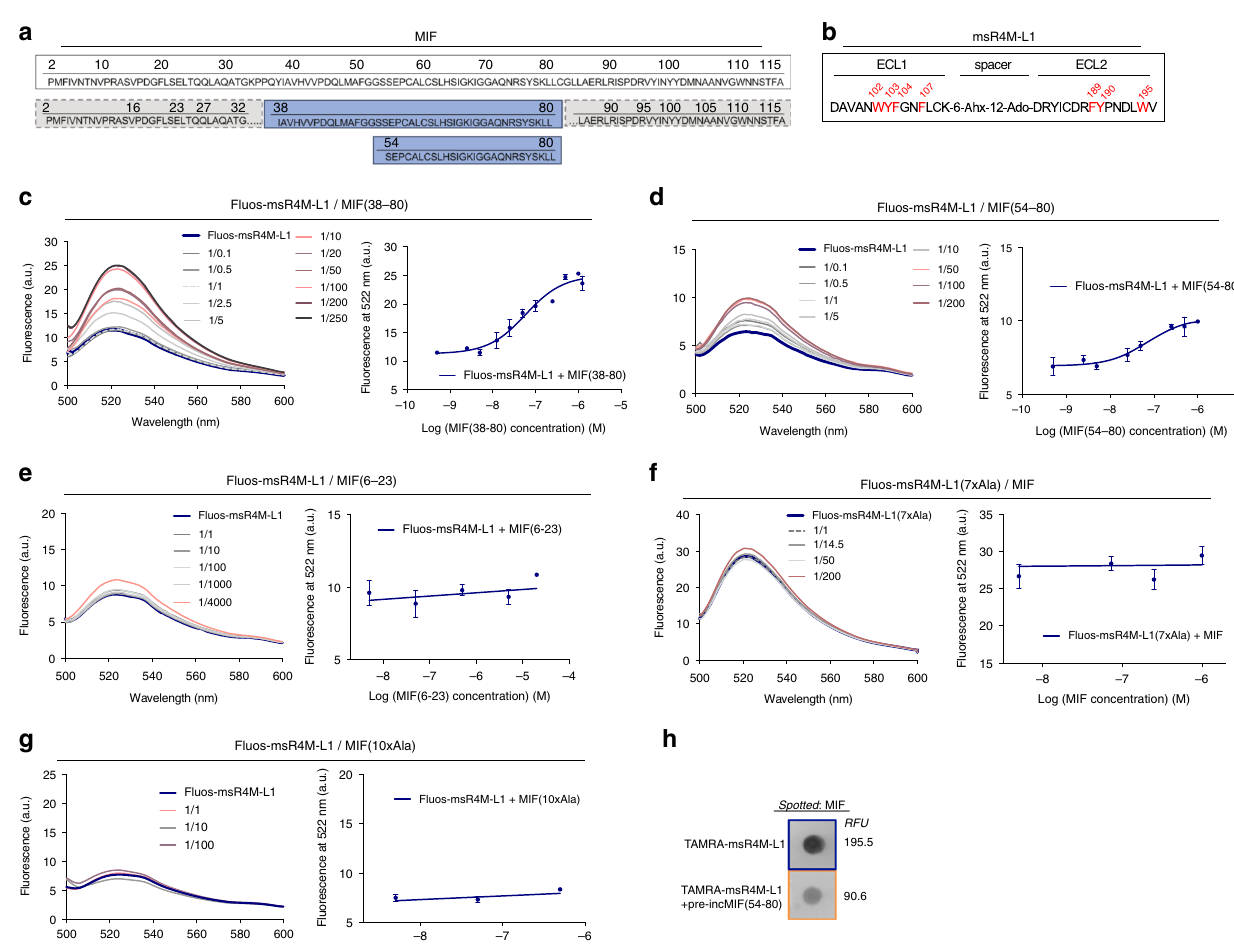
Fig. 2 Mapping of the MIF/msR4M-L1 core binding region and complex disruption by mutations. a Amino acid sequence of human MIF (boxed, top). The msR4M-L1 binding core region of MIF (sequence 38 – 80 and 54 – 80) is indicated in blue, while non-binding stretches are in gray (bottom). b Sequence of msR4M-L1. Aromatic residues identi fi ed by peptide array to be critical for MIF binding are highlighted in red. c – e Nanomolar af fi nity binding of msR4M- L1 to MIF(38 – 80) ( c ) and MIF(54 – 80) ( d ), but not MIF(6 – 23) ( e ), as determined by fl uorescence spectroscopy. Emission spectra of Fluos-msR4M-L1 alone (blue; 5 nM) and with increasing concentrations of MIF(38 – 80) ( c ), MIF(54 – 80) ( d ), and MIF(6 – 23) ( e ) (left panels; representative titrations); binding curves derived from the fl uorescence emission at 522 nm (right panels). f – g Binding of msR4M-L1 to MIF is blunted when aromatic residues in msR4M-L1 are substituted by Ala in analog msR4M-L1(7xAla) ( f ) or when N-loop residues in MIF are mutated to Ala in MIF(10xAla) ( g ). Fluorescence spectroscopy and binding curve as in c – e . Data in right panels of c – g are means ± SD from three independent experiments. h Dot blot shows that binding of TAMRA-msR4M-L1 to spotted MIF is attenuated by MIF(54 – 80). 400 ng spotted MIF was probed with TAMRA-msR4M-L1 + / − 2-fold molar excess of MIF(54 – 80); RFU, relative fl uorescent units. The blot shown is one of three dot blots performed. msR4M-L1, MIF-speci fi c CXCR4 mimic-L1; MIF, macrophage migration-inhibitory factor. Source data are provided as a Source Data fi